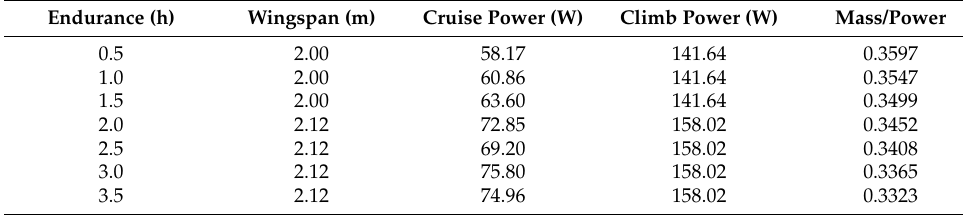
Figure 11. Mass/power ratio as a function of wingspan for different flight endurance. Table 5. Main parameters of the aircraft for each flight endurance range.